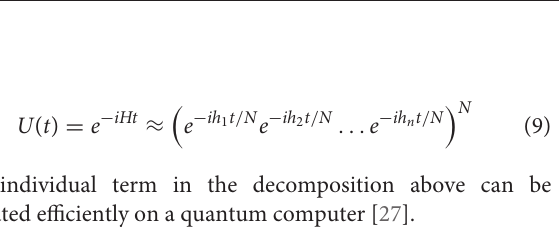
FIGURE 1 | The circuit for measuring the density matrix. The half before the dashed line is used for evolving the state to time t , the half after is used for doing the measurement of an observable at time t via phase